Question: Which visualization type does this figure use?
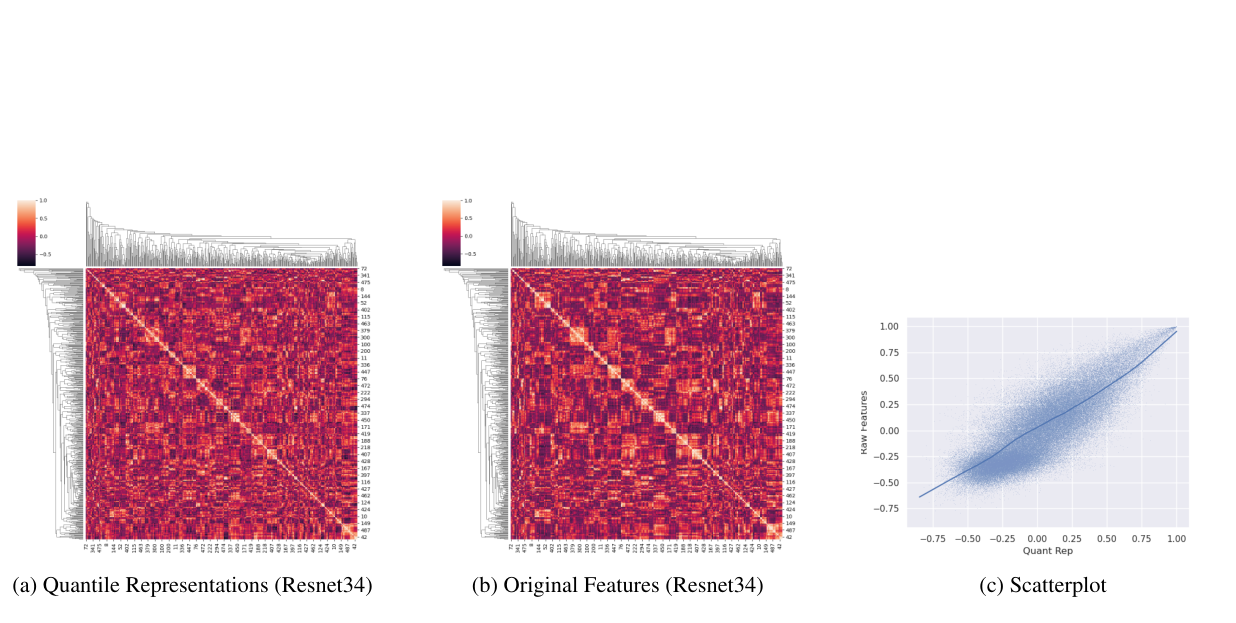
Answer: scatter